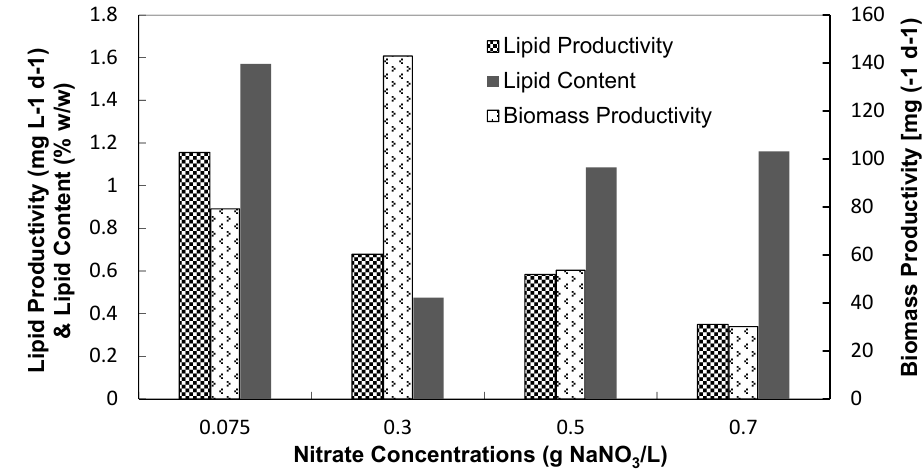
Figure 10. Biomass productivity, lipid contents, and lipid productivity of P. cruentum at optimum temperature (20 °C) and light intensity (140 µE m − 2 s − 1 ) with different growth nutrient levels (0.075, 0.3, 0.5, or 0.7 g NaNO 3